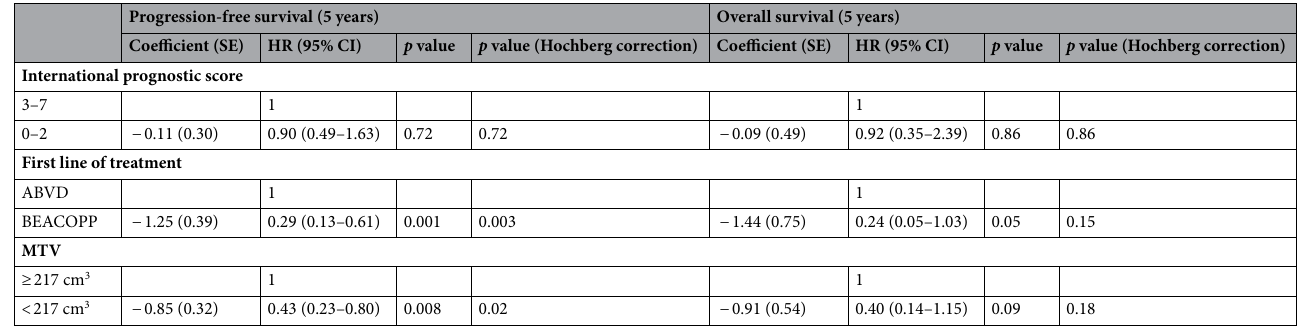
Table 2. Multivariate